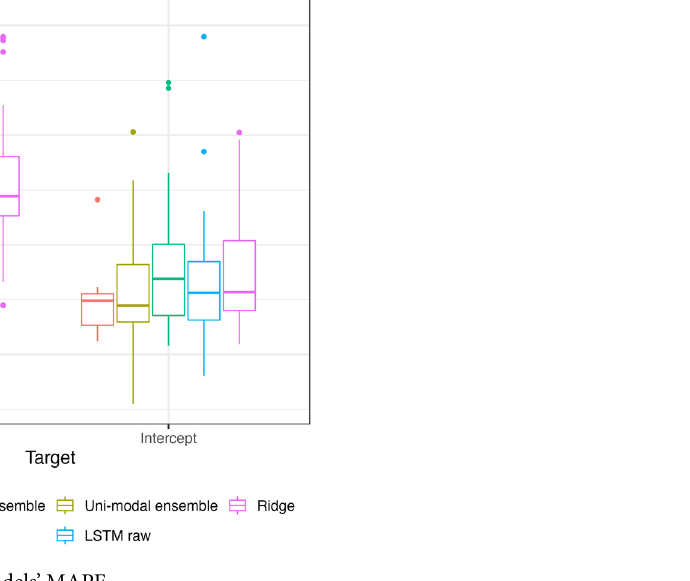
Figure 6. Distributions of models’